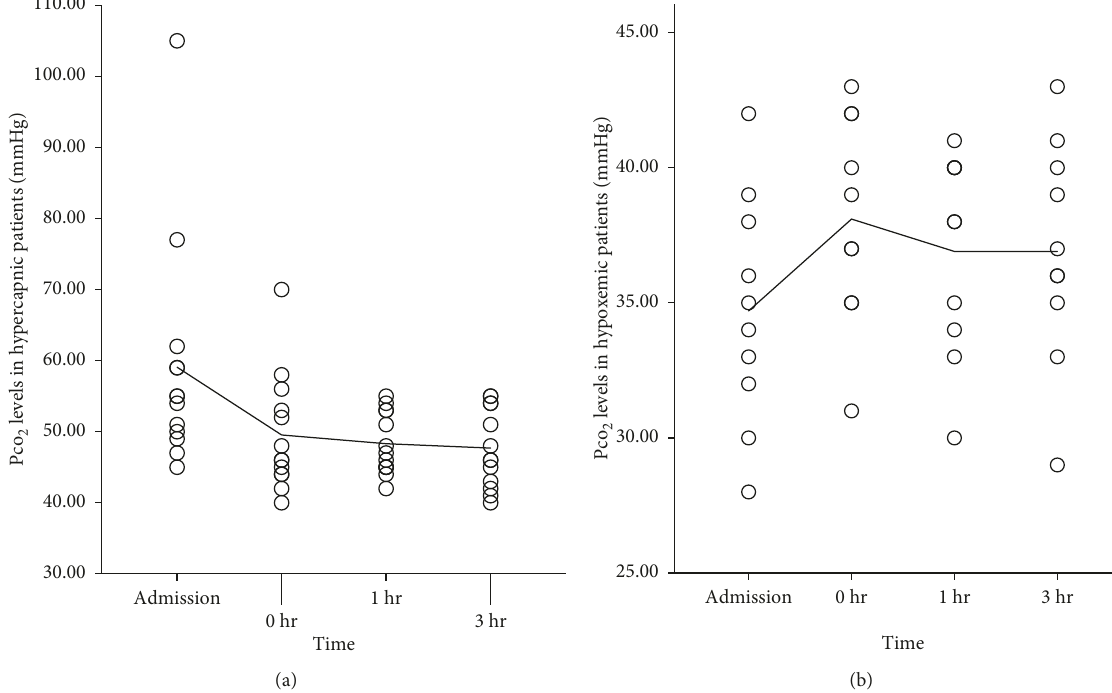
Figure 4: PCO 2 levels of hypercapnic and purely hypoxemic ARF patients at admission, just before the application of the device (0hr), 1hour after the application of the device (1hr), and 3hours after the application of the device (3hr). The line corresponds to the mean value of each